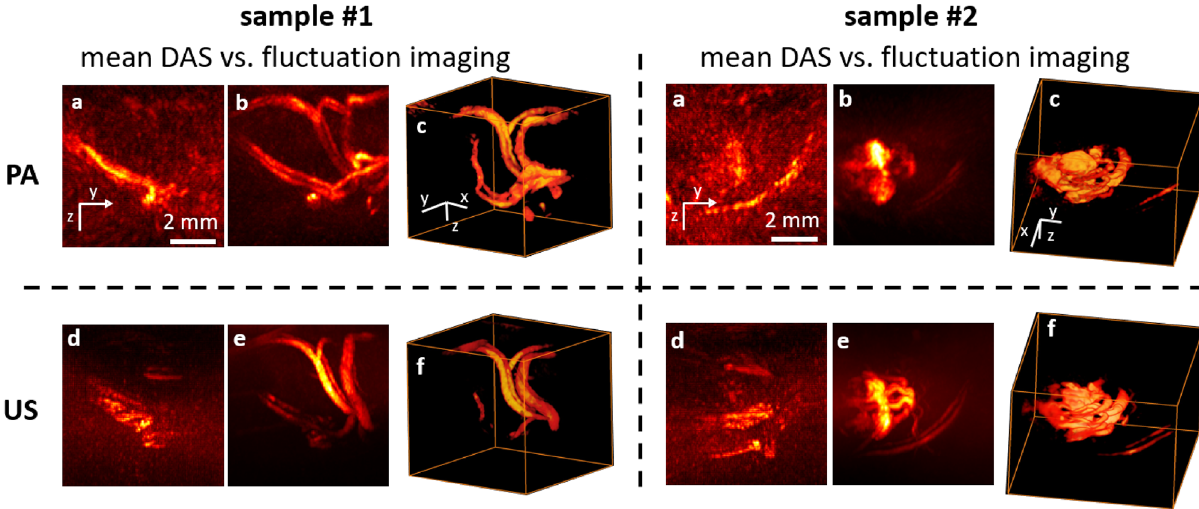
Figure 2. Three-dimensional photoacoustic fluctuation imaging (PAFI, ( b,c ), top row) and Ultrasound Power Doppler (US-PwD, ( e,f ), bottom row) imaging, along with DAS photoacoustic imaging ( a ) and DAS ultrafast ultrasound imaging ( d ). The images represent blood vasculature obtained in two different representative chicken embryos. Photoacoustic images correspond to photoacoustic signals acquired at (cid:31) maximum intensity projections (MIP) along the x-direction through 3D images. ( c,f ) 3D